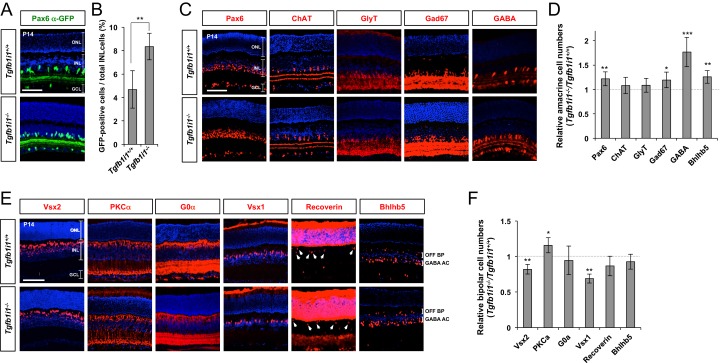
Elevated GABAergic amacrine cell number in Tgfb1i1−/−mouse retinas.(A) Pax6 α-enhancer-active cells in P14 Tgfb1i1+/+ and Tgfb1i1−/−littermate mouse retinas were visualized by immunodetection of GFP expressed from the P6α-CreiGFP transgene. ONL, outer nuclear layer; INL, inner nuclear layer; GCL, ganglion cell layer. (B) GFP-positive cell population in 250 μm x 250 μm retinal area. (C) P14 Tgfb1i1+/+ and Tgfb1i1−/−littermate mouse retinas stained with antibodies detecting amacrine cell subtype-specific markers. Pax6, pan-amacrine cells; ChAT, cholinergic amacrine cells; GlyT1, glycinergic amacrine cells; GABA, Gad67 and Bhlhb5 (in the bottom half of INL in the images in E), GABAergic amacrine cells. (D) Fold-changes of amacrine cell numbers in P14 Tgfb1i1−/− retinas compared to Tgfb1i1+/+ littermate retinas. (E) P14 Tgfb1i1+/+ and Tgfb1i1−/−mouse retinas stained for bipolar cell-specific markers. Vsx2, pan-bipolar cell marker; PKCα, rod bipolar cells; G0α, rod and ON-cone bipolar cells; Vsx1, OFF bipolar cells; Recoverin, photoreceptors (in the ONL) and type-2 OFF bipolar cells (in the INL); Bhlhb5 (in the top half of INL), type-2 OFF bipolar cells. (F) Fold-changes in marker-positive cell numbers in Tgfb1i1−/− retinas compared to Tgfb1i1+/+ littermate retinas. Values on the Y-axes of B, D, and F are averages. Error bars indicate STD (n = 4, three litters); *p<0.05; **p<0.01; ***p<0.001. Scale bars in the pictures, 100 μm.